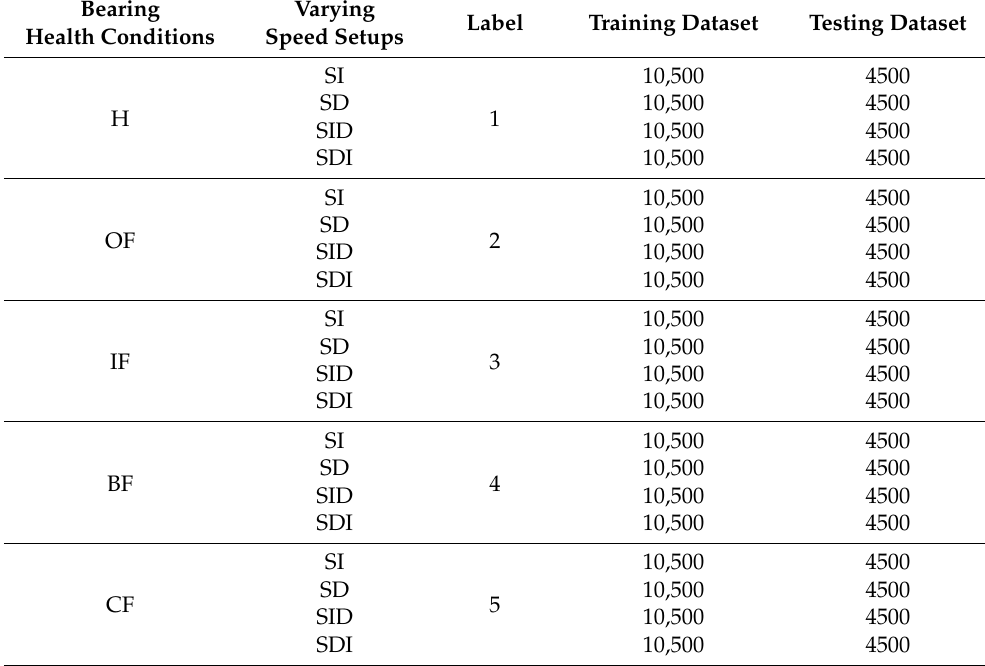
Table 1. Introduction of bearing dataset.